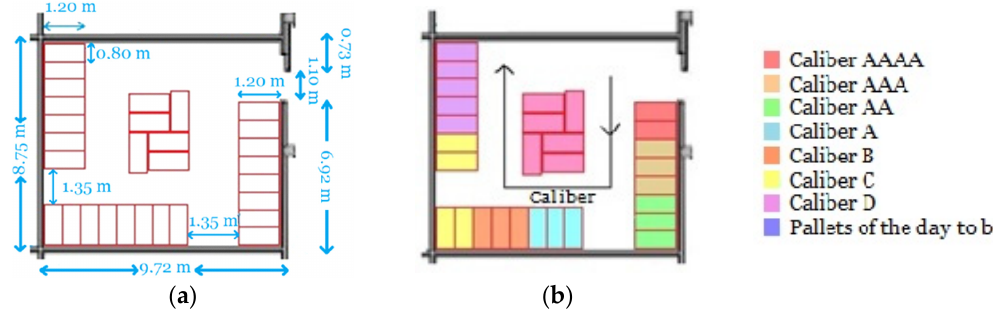
Figure 10. New layout of the cold room for the finished product. ( a , b ) New layout of the cold room for the finished